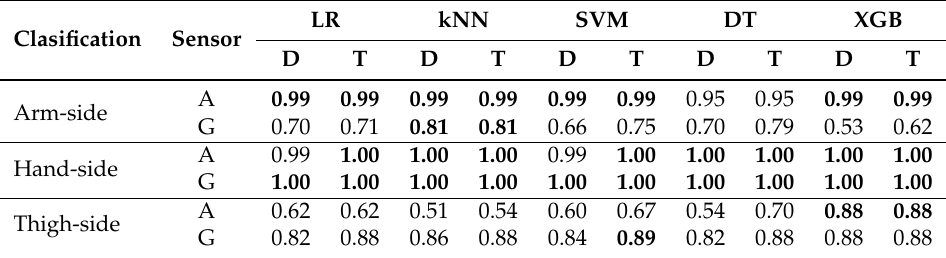
Table 5. Result of optimized classifiers for arm-side, hand-side and thigh-side classifications.